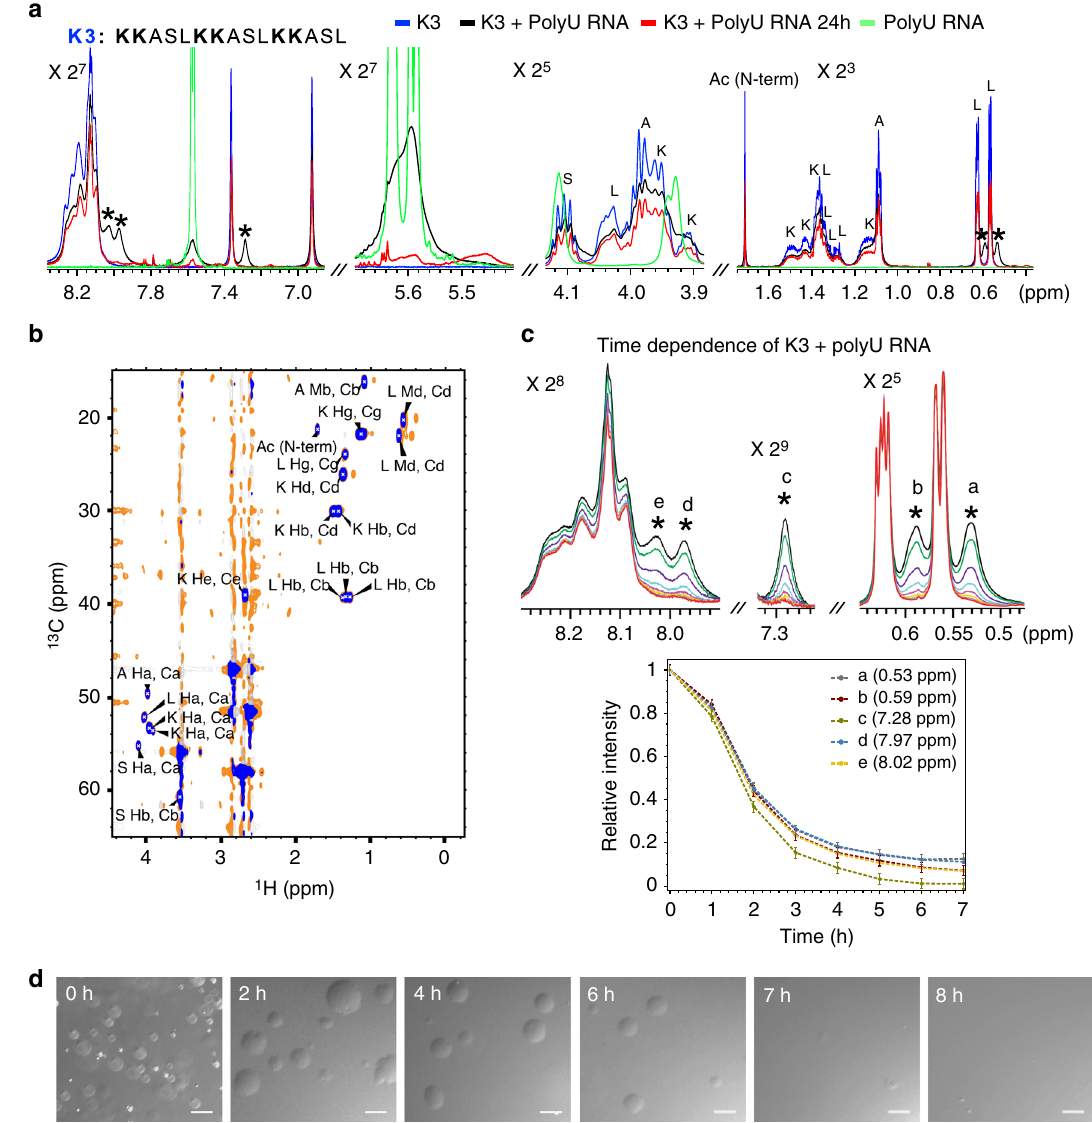
Fig. 3 NMR spectroscopy and temporal stability of lysine-driven condensation. a 1D 1 H NMR spectra of the lysine-rich peptide K3 (1 mM; blue), K3 with polyU RNA forming liquid droplets (1 mM K3 and 1 mg ml − 1 polyU RNA; black) and the same sample after 24 h (red), as well as polyU RNA alone (1 mg ml − 1 ; green). Peptide NMR signals, which are characteristic for the interaction with polyU RNA, are marked with asterisks. b 2D 1 H − 13 C HSQC NMR spectrum of K3 (blue) and K3 with polyU RNA (orange). Cross-peaks were labeled according to amino acid-speci fi c chemical shift values. The two K3/ RNA-speci fi c NMR signals at 1 H frequencies of 0.53 and 0.59 ppm (marked with asterisks in a ) were also present in the 2D 1 H- 13 C HSQC NMR spectrum and have identical 13 C chemical shifts as the two leucine C δ resonances of K3 in the absence of polyU RNA. c Temporal stability of K3 droplets as monitored by the time-dependent decrease of NMR signals. (Top) 1D 1 H NMR spectra of K3 at 0, 1, 2, 3, 4, 5, 6, and 7 h with K3/RNA-speci fi c signals labeled from a – e . (Bottom) Time-dependent decrease in normalized signal intensity of K3/RNA-speci fi c signals. Error bars are based on signal-to-noise ratios in the NMR spectra. The peptide solution became clear after ~ 7 h. d DIC micrographs of a sample containing K3 (1 mM) and polyU RNA (1 mg ml − 1 ) over a period of 8 h. Liquid droplets disappeared after about 7 – 8 h. Scale bar, 10 μ fi t could not describe the data at times longer than 10 s (BIC (Axelrod) = − 598). Thus, the lysine residues appear to dominate the diffusional properties of K2R1. The combined data suggest a more open and less entangled molecular mesh in lysine-rich condensates. differ from when mixing K3 with RNA (Fig. 3a and Supplementary Fig. 3b – d). Resonances speci fi c for lysine/RNA-interactions were detected in the leucine C δ region near ~ 0.6 ppm, and also at ~7.28 ppm and ~ 8 ppm (see peaks marked with * in Fig. 3a).